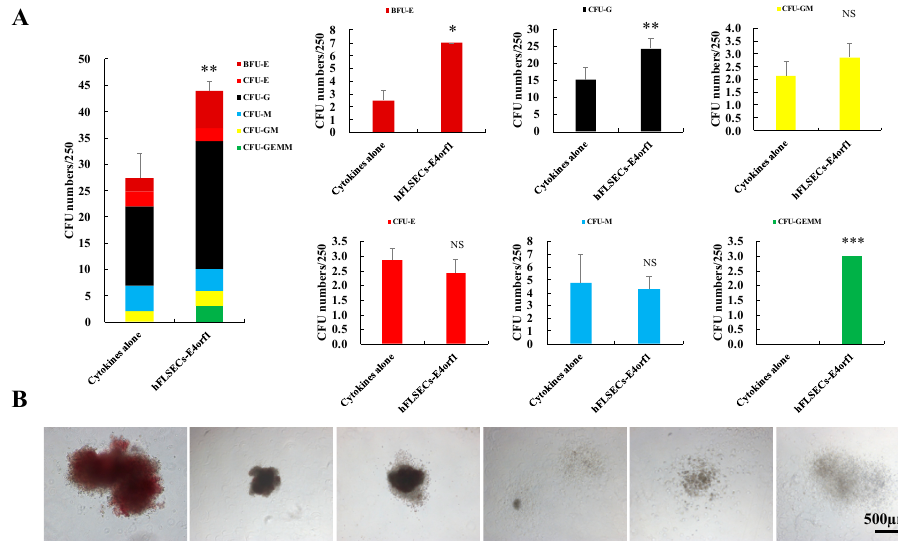
Figure 4. CD34 + hCB cells coculture with hFLSECs-E4orf1 resulted in increased number of CFUs in vitro while having the capacities of repopulating and multilineage differentiation in vivo. ( A and B ) Count of different colony types of methylcellulose-based clonogenic assay performed on expanded CD34 + hCB cells. Scale bars: 500 μ m. Data represented as mean ± SEM. NS means “no significant difference”. n = 6. * p < 0.05, ** p < 0.01, *** p < 0.001.